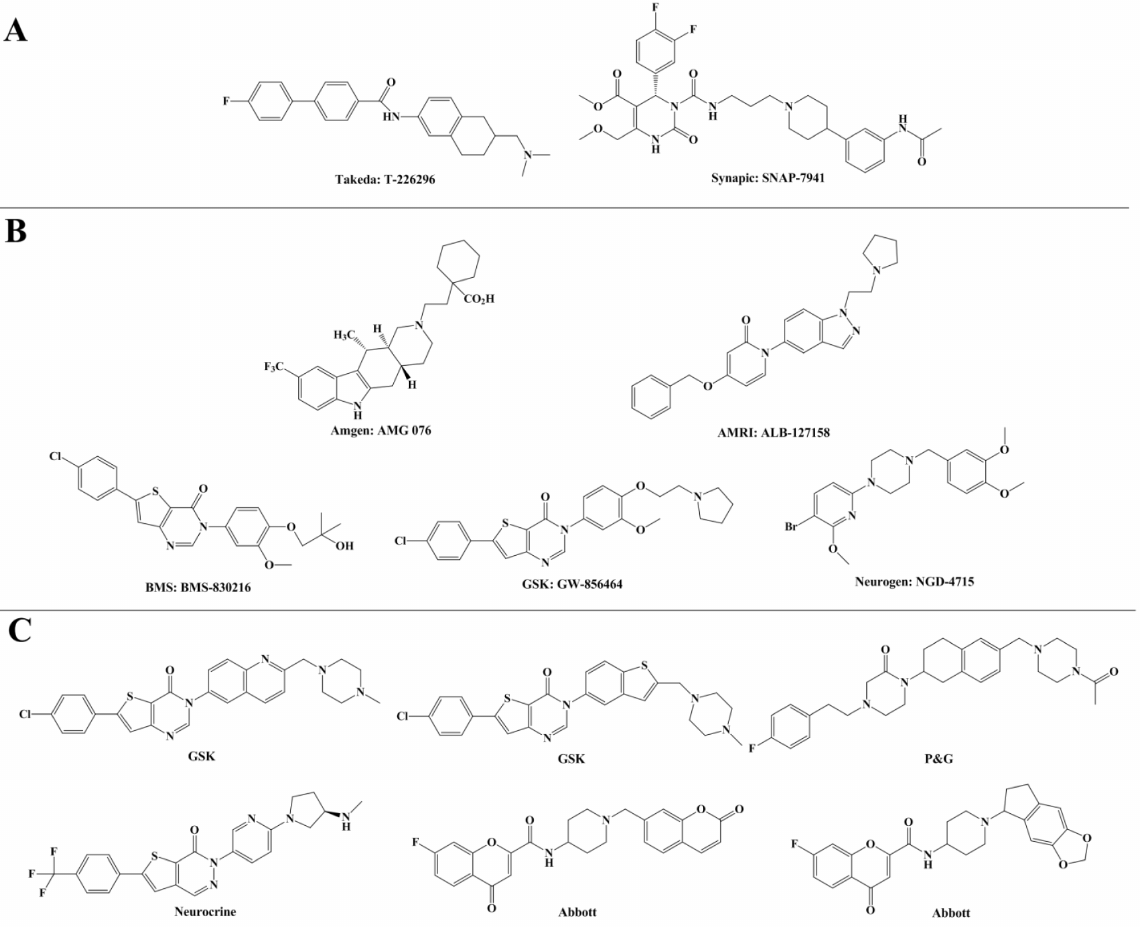
Figure 1. ( A ) Two pioneer melanin concentrating hormone receptor 1 (MCHR1) antagonists; ( B ) Five MCHR1 antagonists in Phase I clinical trials; ( C ) Several potent MCHR1 antagonists with good human ether-a-go-go related gene (hERG)